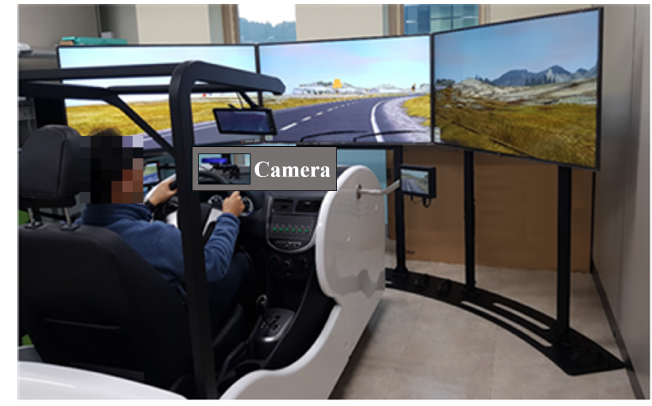
Figure 2. Driving simulator.